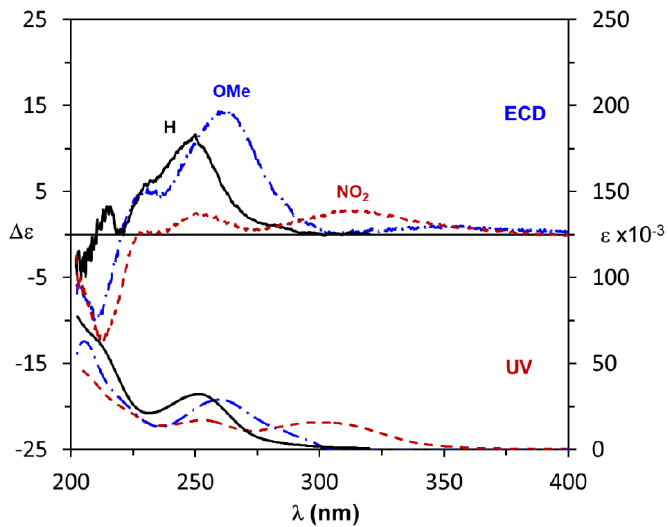
Figure 7. UV and ECD spectra of the biphenylamides ( S )- 4ca (solid black line), ( S )- 4cb (dashed dotted blue line) and ( S )- 4cc (dashed red line).